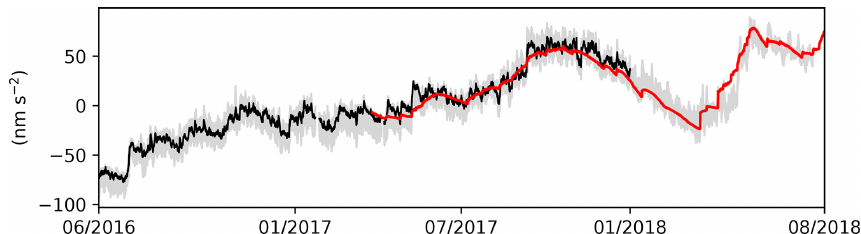
Figure 4. Measured gravity residuals reduced for all available large-scale model combinations (in grey). Model combination Atmacs, ODT, and NOAH025 in black. Red line shows the local gravity